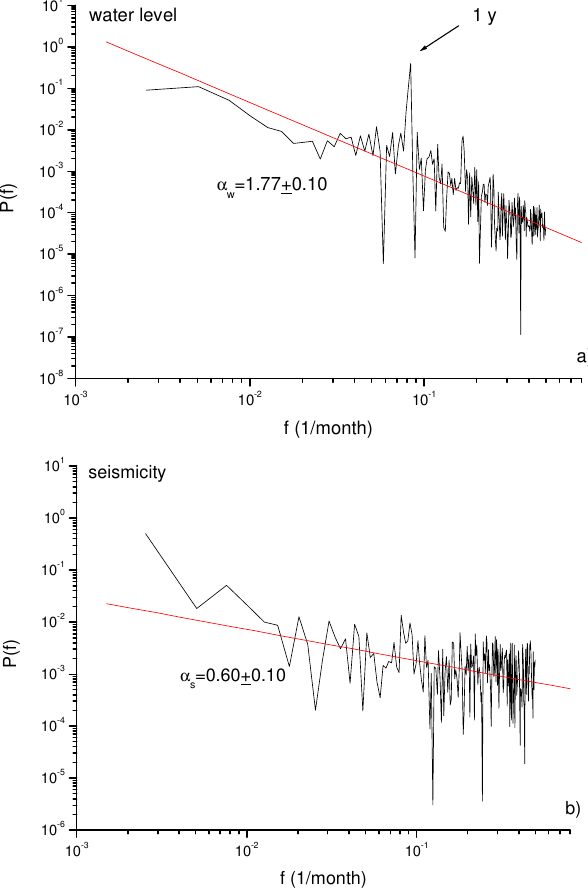
Fig. 4. Power spectrum of the monthly water level (a) and the monthly number of events (b) .